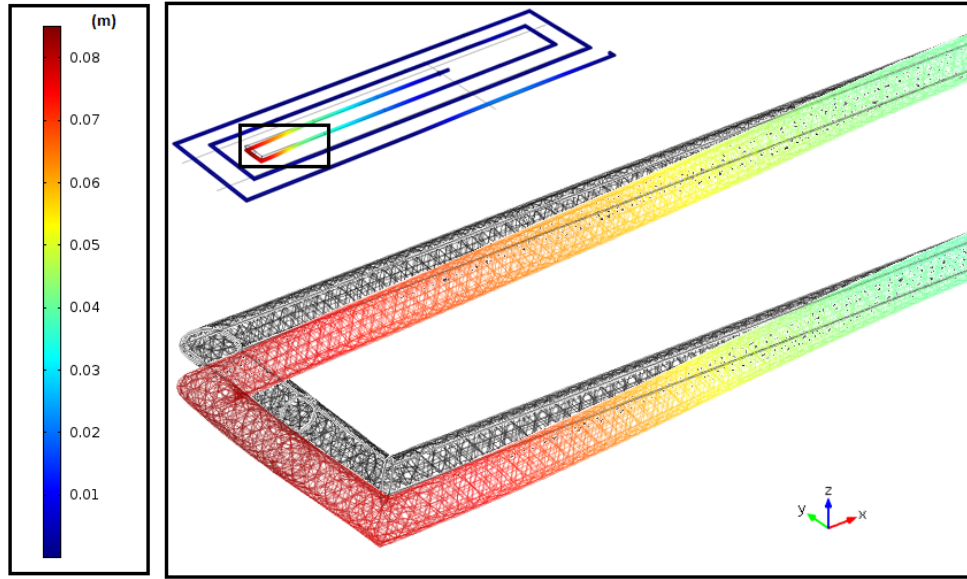
Figure 10. Mesh in original and final configurations for t = 0.21